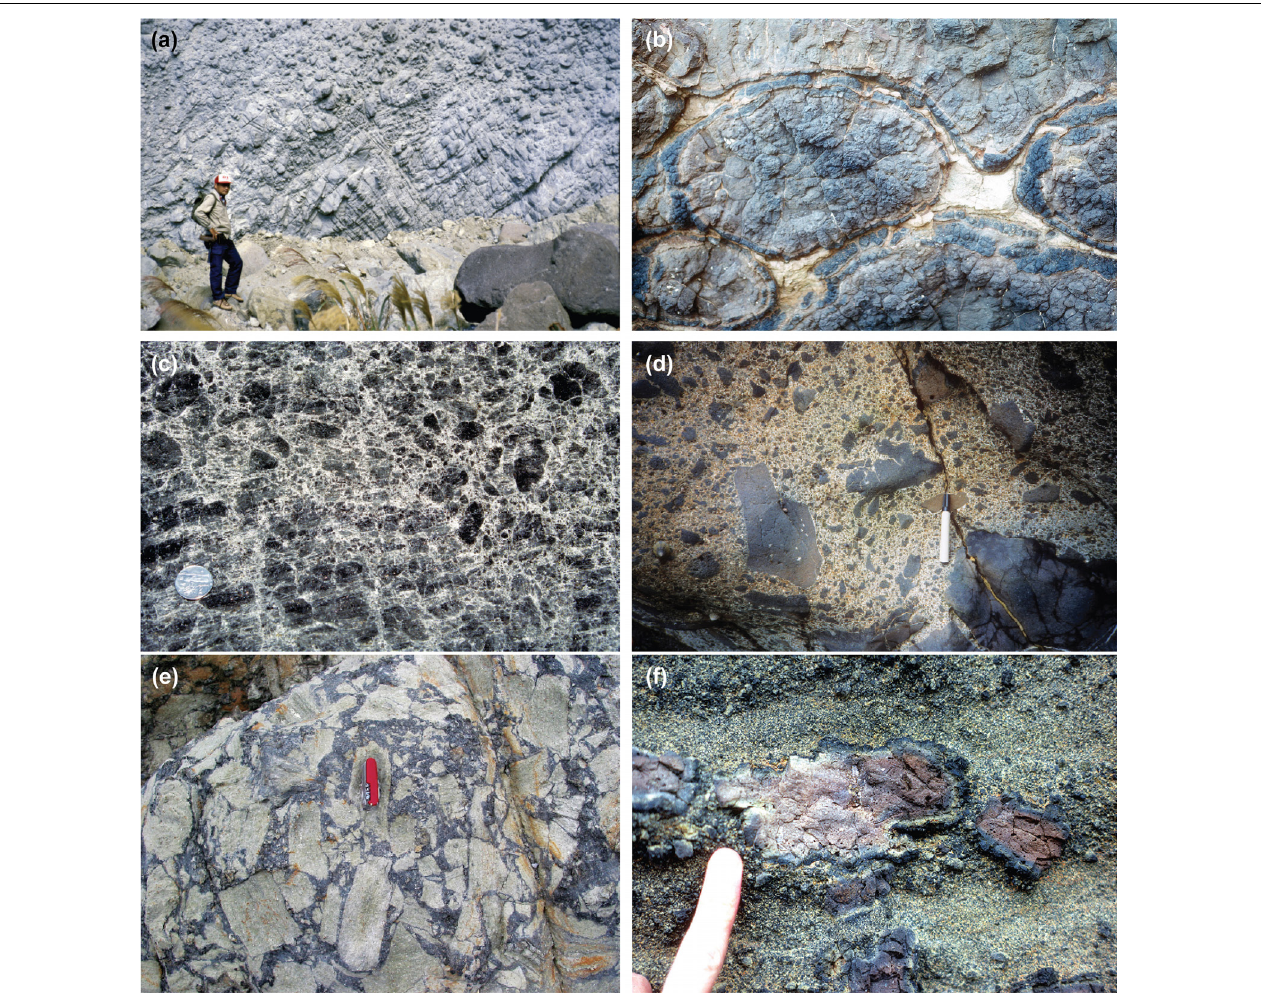
FIGURE 7 | Prehistoric subaqueous lavas and hyaloclastite. (a) Quench fragmented submarine Miocene dacite lava dome with in situ hyaloclastite breccia, Kariba, Hokkaido, Japan. Note the transition from the coherent to in situ , jigsaw-fit brecciated, flow-banded core, to progressively more intensively fragmented, finer breccia outwards. (b) Coherent to in situ fractured, Eocene-Oligocene, basaltic pillow lava with black, chilled, polygonally quench fractured glassy margins, and an internal fracture network, separated by bioclastic limestone (pale color), Boatmans Harbour, Oamaru, New Zealand. (c) In situ to clast-rotated pumice hyaloclastite breccia, Cala di Feola, Ponza, Italy. (d) Clast-rotated, probably resedimented, basaltic hyaloclastite breccia resulting from pervasive quench fragmentation of fluidal Eocene-Oligocene pillow lavas, Oamaru, New Zealand. (e) Rhyolite clast (pale) peperite breccia with black mudstone matrix, Late Devonian Boyd Volcanic Complex, Mimosa Rocks National Park, New South Wales, Australia. (f) Fractured and broken, poorly vesicular, submarine fire fountain spatter clast, in a matrix of blocky, coarse ash size, glassy fragments, fragmented by quench fragmentation in the submarine fire fountain, Miocene, Ryugazaki, Oshoro Peninsula, Hokkaido, Japan. (From Cas et al., 2003, Figure 8 , reproduced under rights granted to authors by American Geophysical Union https://publications.agu.org/author-resource-center/usage-permissions/).